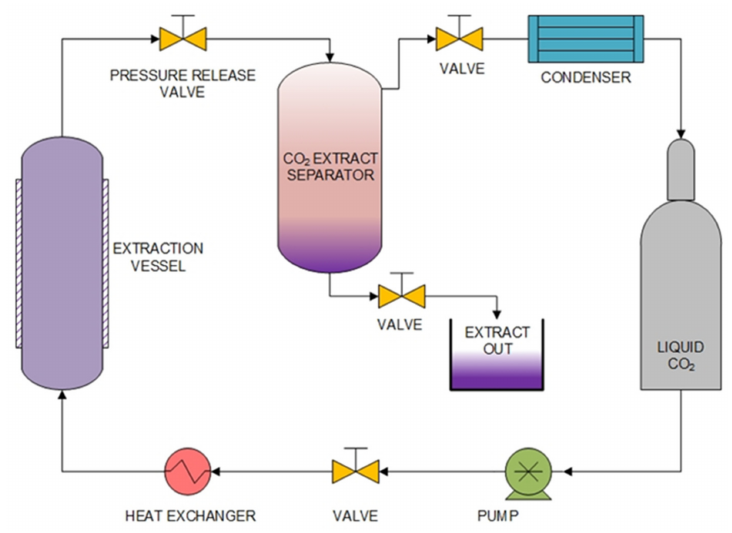
Figure 7. Schematic diagram of supercritical fluid extraction